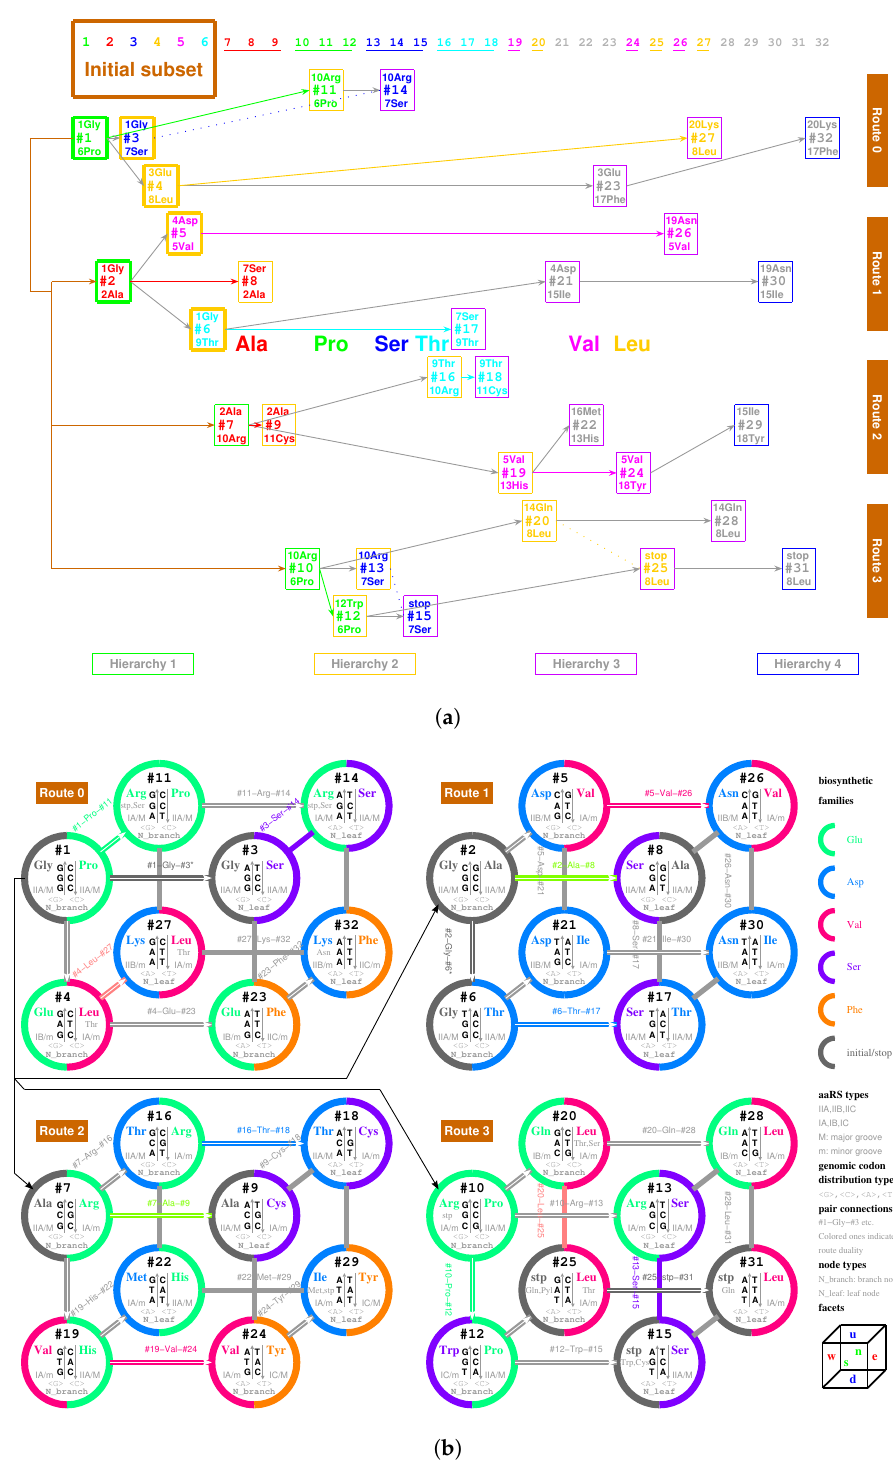
Figure 3. ( a ) Cooperative recruitment of codons and amino acids. Codon pairs are plotted from left to right according to their recruitment order. The initial subset plays a crucial role in the expansion of the genetic code along the roadmap. The 6 biosynthetic families of the amino acid are distinguished by different colours. ( b ) The cubic roadmap. This is a revised roadmap Figure 1a to indicate the symmetry in the evolution of the genetic code. The four routes are represented by four cubes, respectively. Pair connections are marked besides the evolutionary arrows. Route dualities are indicated by same colours for the corresponding pair